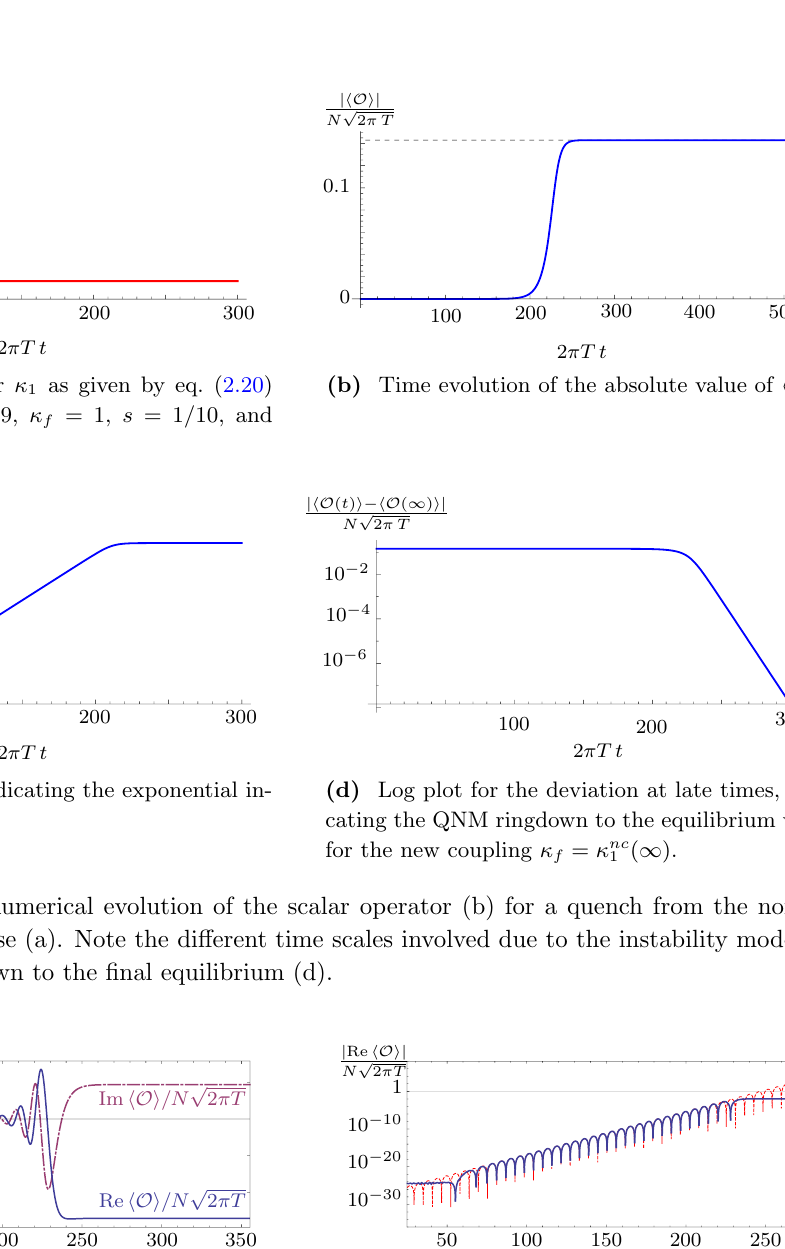
( t ). The red curve in (b) is a numerical 1